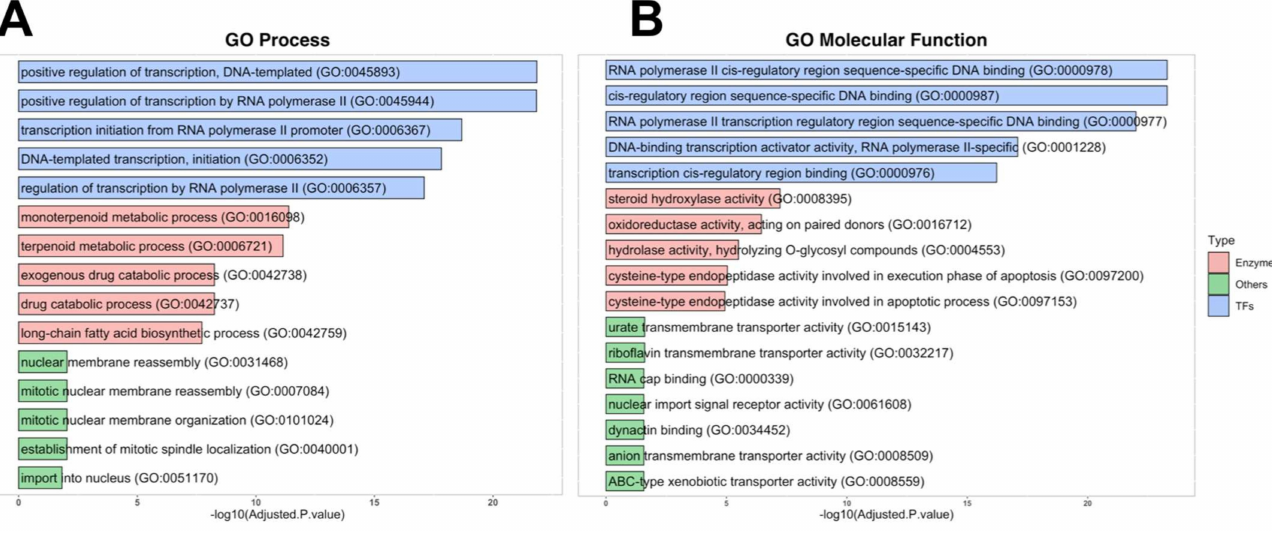
Figure 2. Main GO ontologies and pathways of 4MU targets. ( A )—GO Process ontologies, ( B )—GO Molecular